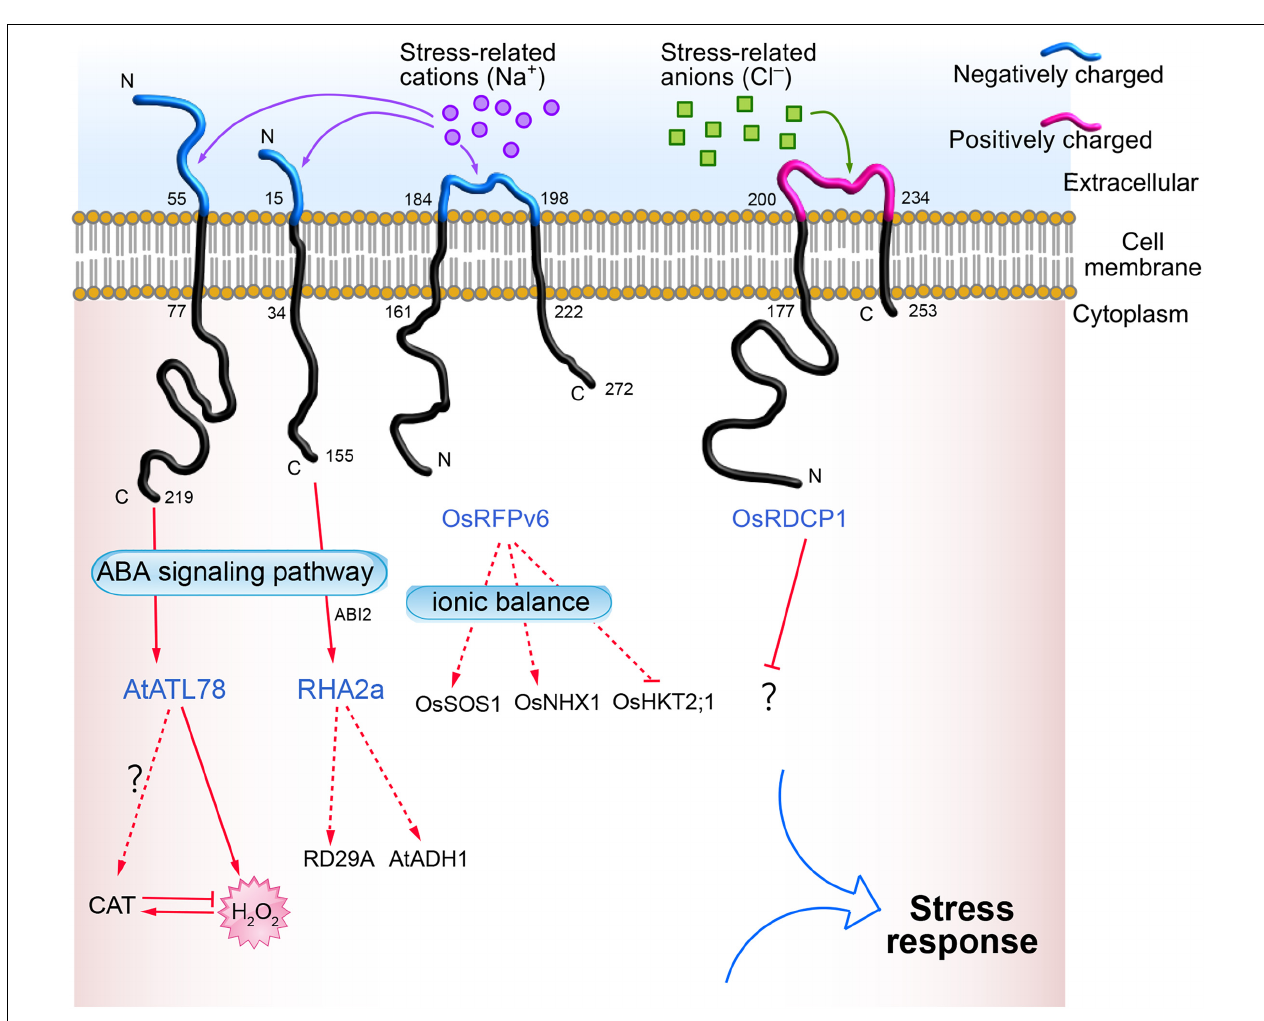
FIGURE 1 | Bioinformatics analysis of transmembrane domains of RING zinc finger proteins located on the plasma membrane. The online tools TMHMM Server v. 2.0 (http://www.cbs.dtu.dk/services/TMHMM/) and Expasy ProtParam (https://web.expasy.org/protparam/) were used to for the analysis.